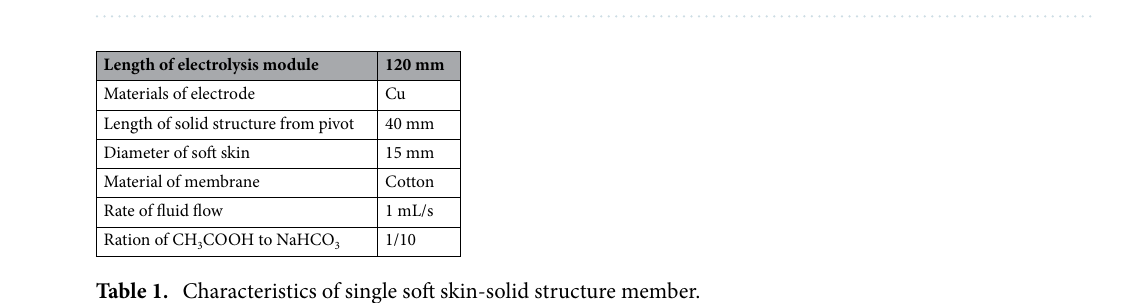
Figure 2. Test equipment including Gas outlet port for depressurizing the swelling soft skin, pump for flowing fluid (acetic acid) through fluid tube and inflation tester for measurement of displacement over time.